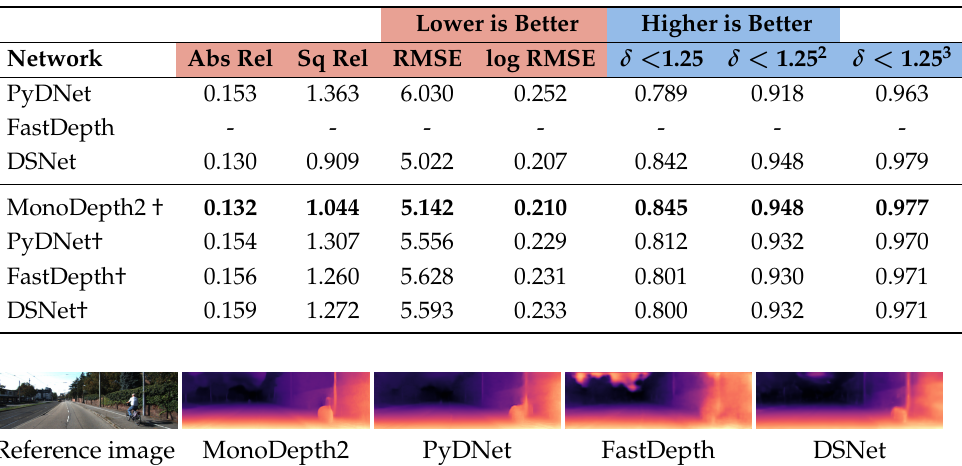
Table 1. Quantitative results on Eigen split. † indicates models trained according to [26] training framework, otherwise we report results provided in each original paper.